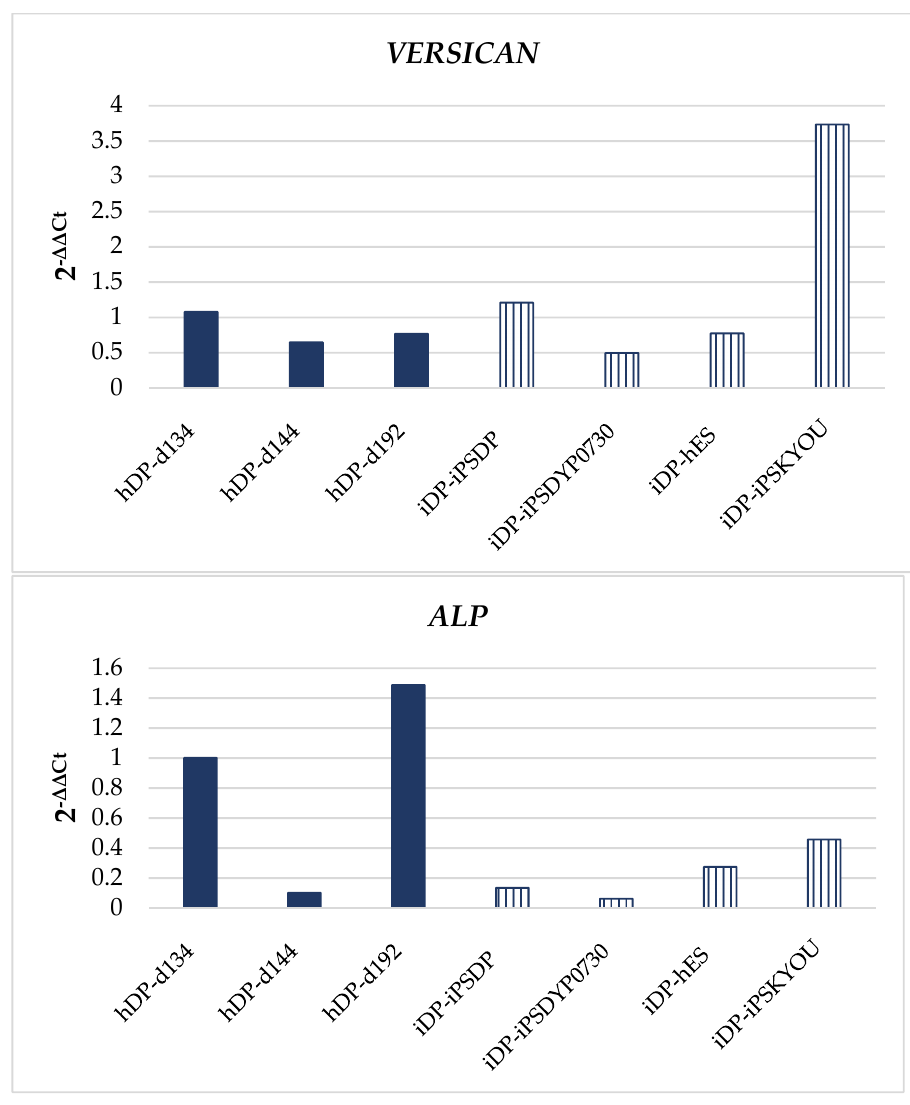
Figure 4. Analysis of the expression of specialized markers in the dermal spheroids: CD44 (green), α SMA (red); VERSICAN (green), Ki67 (red); VIMENTIN (green), FIBRONECTIN (red). Fluores- cence microscopy, the scale length in all pictures is 100 μ m.